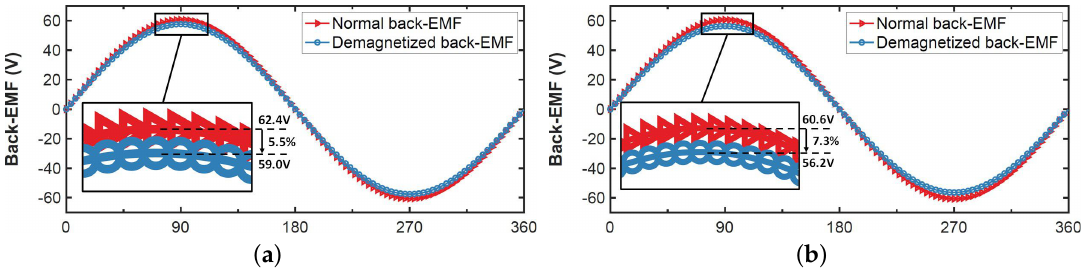
Figure 10. Back-EMF of both candidates before and after current demagnetization. ( a ) Proposed structure; ( b ) Regular